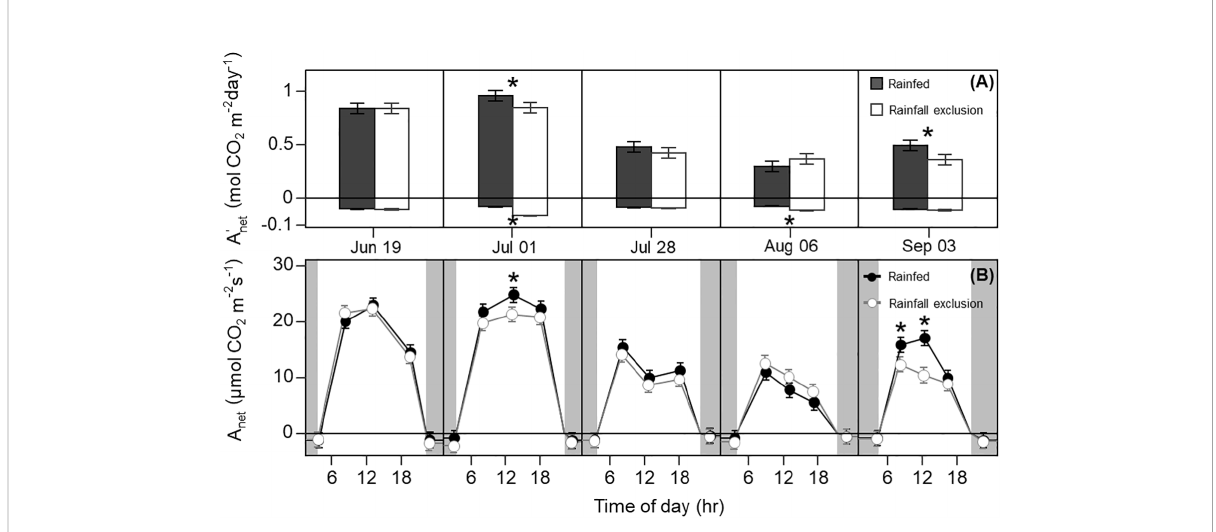
FIGURE 2 Switchgrass daily net CO 2 assimilation ( A 0 net ; A) integrated over each sampling date, and net CO 2 assimilation rate ( A net ; B) at each timepoint during the day, for plants grown under (white fi ll, grey line) and outside (black fi ll, black line) rainfall exclusion shelters. Negative values indicate dark respiration during the night period (A) , and dark respiration at predawn and post-dusk timepoints (B) . Asterisks indicate a signi fi cant difference between treatments (P< 0.05). Data are mean ± S.E. (n =